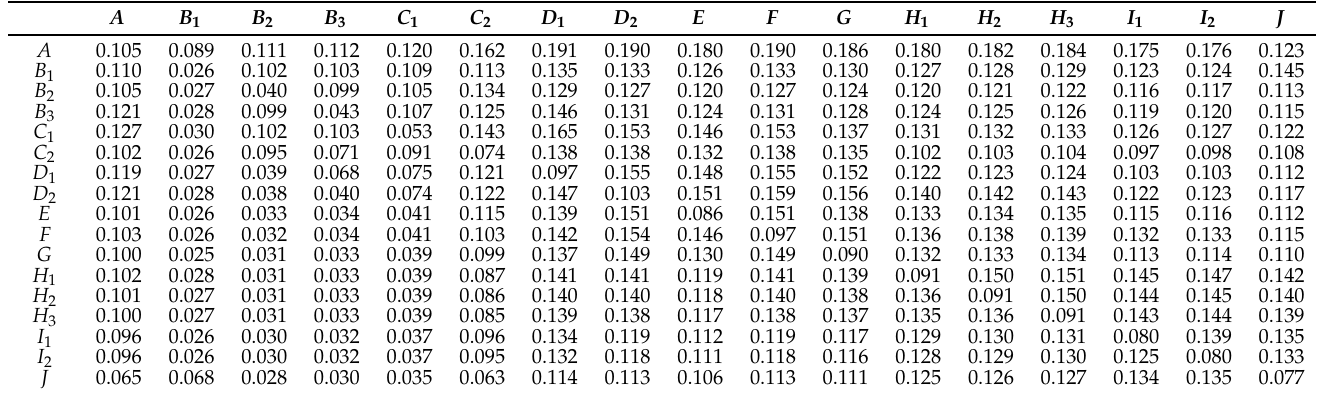
Table 4. Crisp total-relation matrix ( T ) obtained via the CFCS method [62].